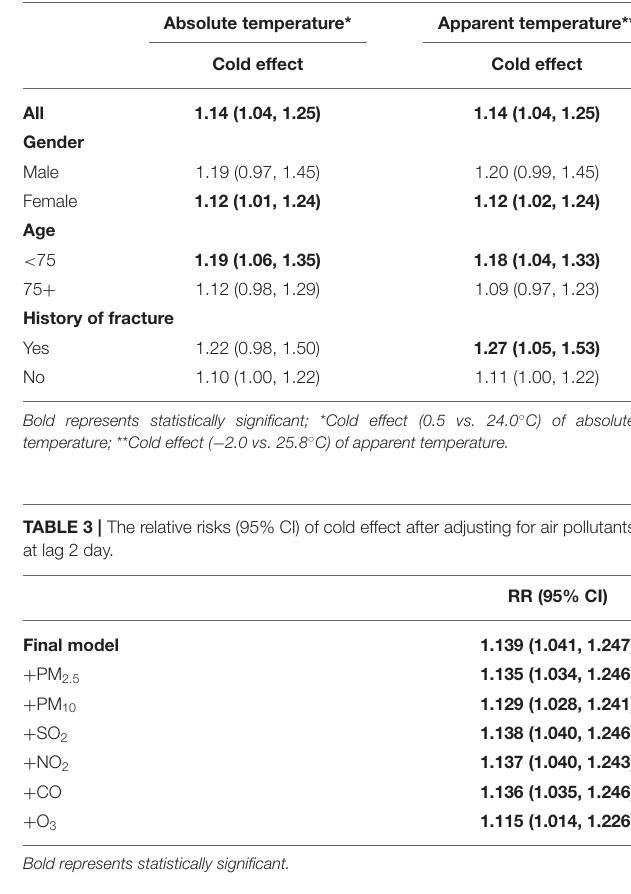
TABLE 2 | The relative risks and 95%CI of cold effect of absolute temperature and apparent temperature on the number of hospitalizations for osteoporotic fractures at lag 2 day.